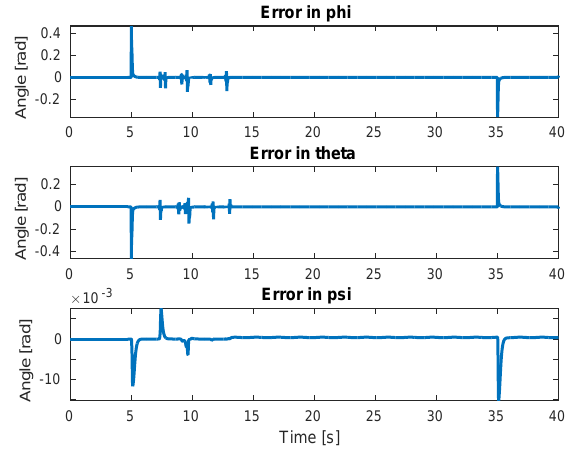
Figure 28. Euler angles tracking errors using an